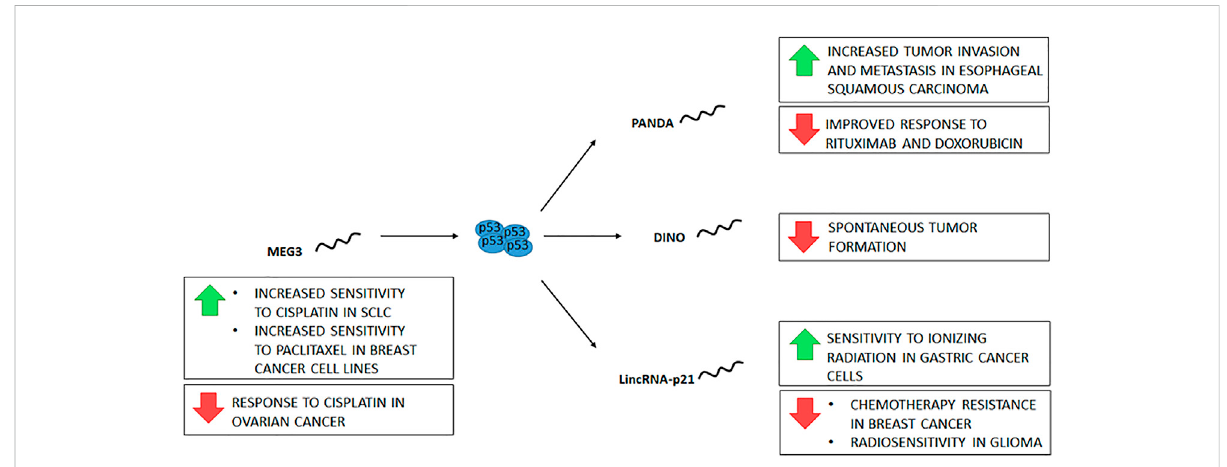
FIGURE 4 lncRNAs participate in the p53 pathway downstream and upstream of p53. Four lncRNAs are depicted relative to p53, along with the identi fi ed consequences of their expression (green arrows) or repression (red arrows), be it experimental or naturally occurring in